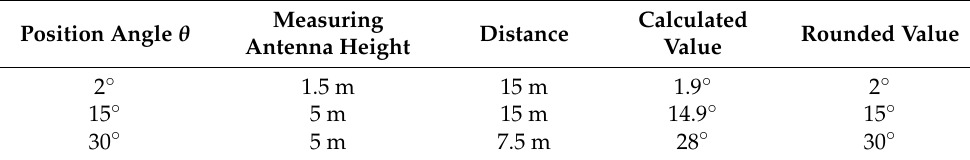
Table 1. Calculated values of distances and angles used in